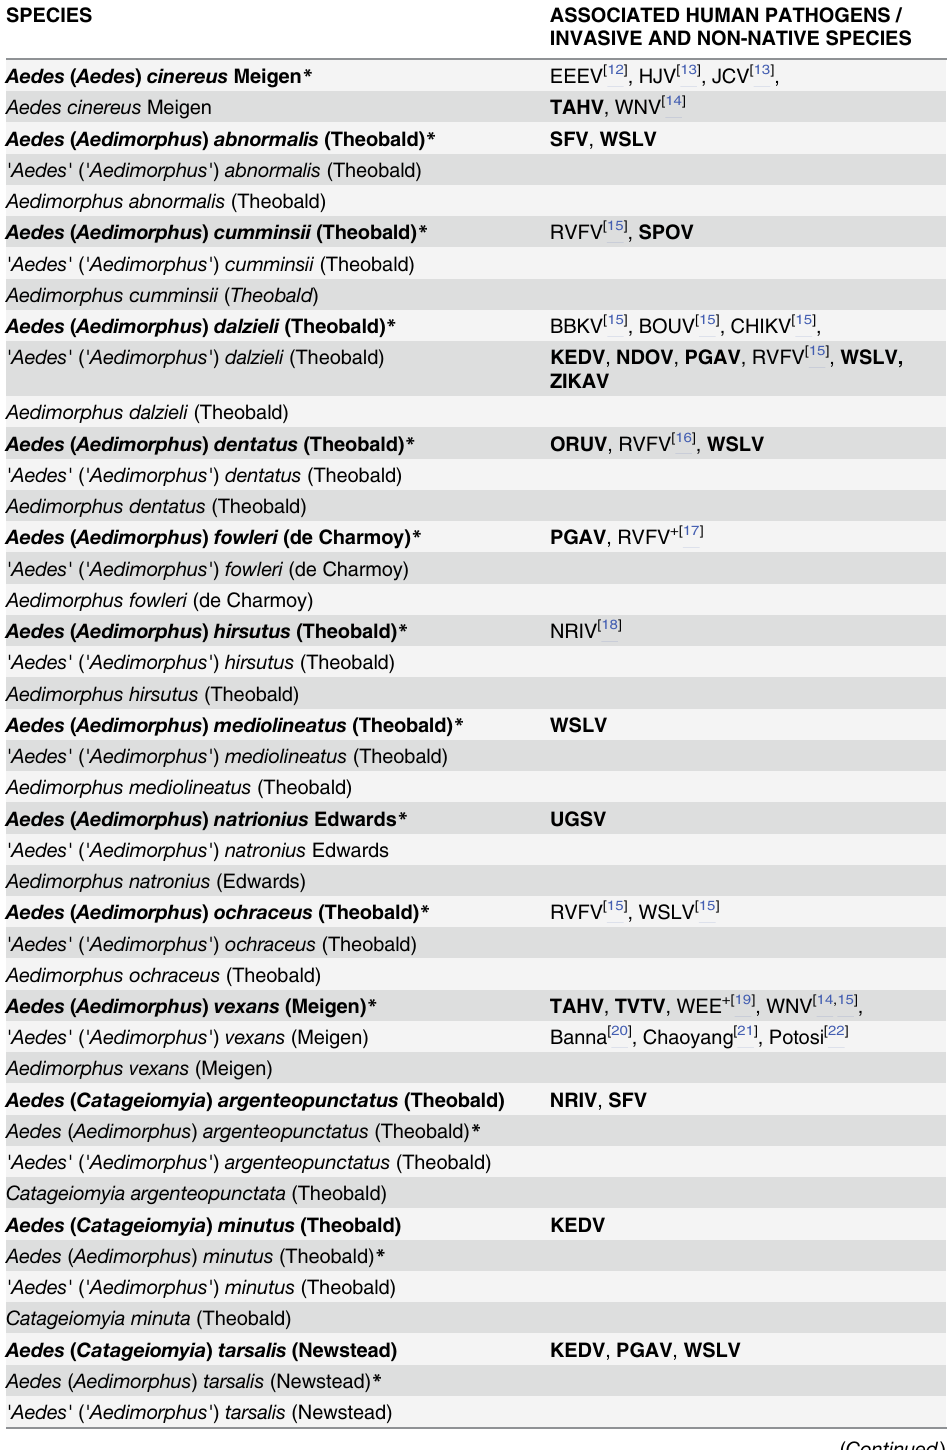
Table 1. Name combinations used since 1977 for selected mosquitoes belonging to Tribe Aedini with associated human pathogens and invasive (established, spreading) or non-native (established, not spreading) behaviors. Names proposed herein are in bold typeface; previous name combinations follow in normal